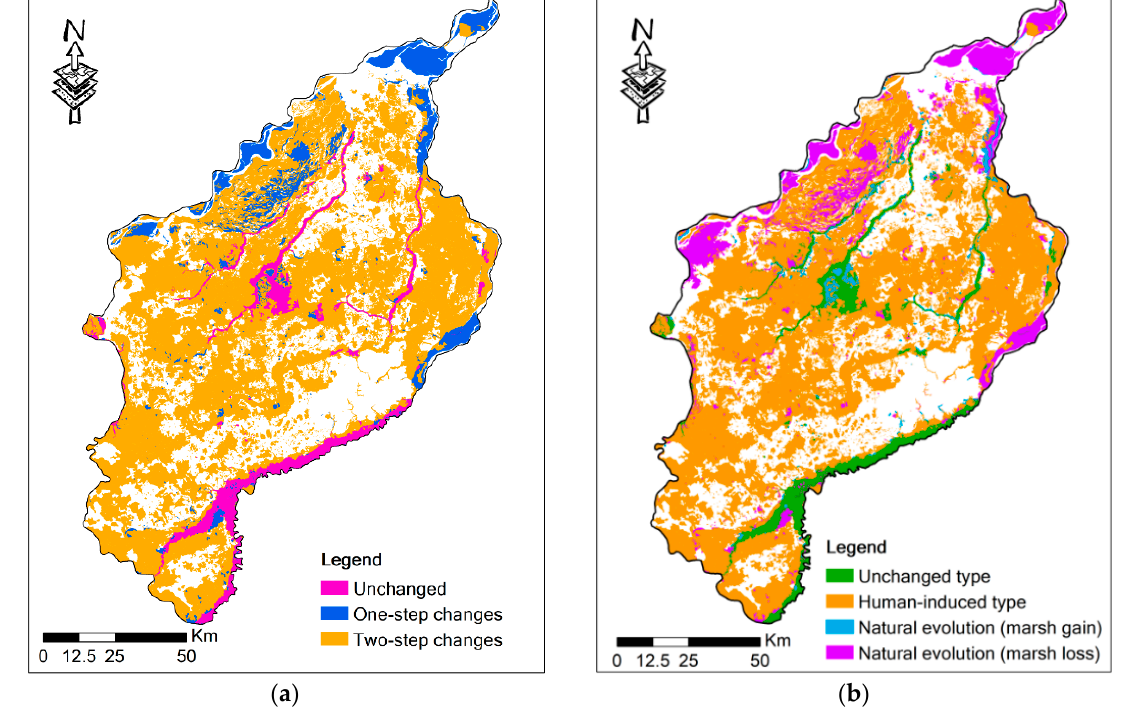
Figure 5. Trajectories of marsh changes, 1965–2015: ( a ) marsh changes with di ff erent steps; ( b ) marsh change